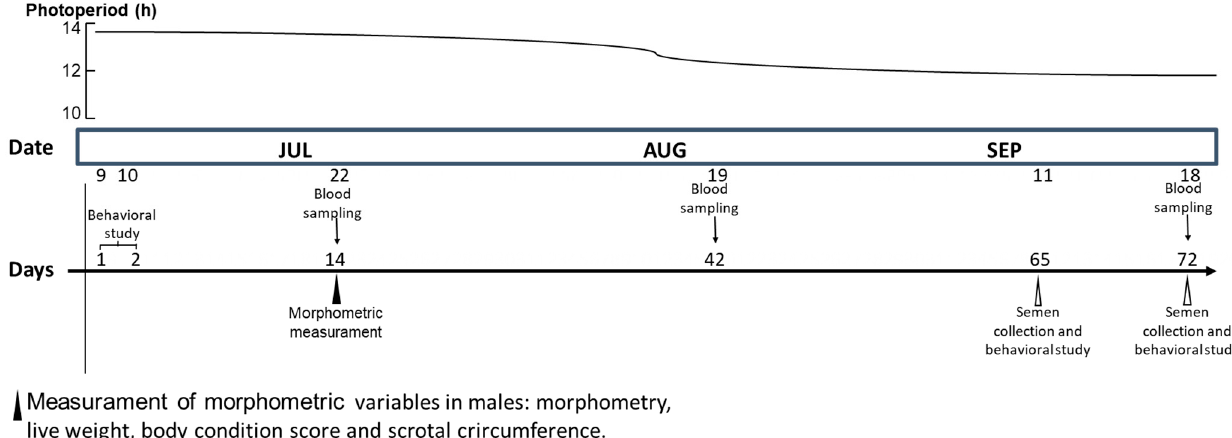
Figure 1. Timeline of the main activities completed in the experimental period. We conducted a behavioral study in all the experimental units ( n = 24) to determine the Dorper males’ social rank, either high or low, under intensive management conditions in northern Mexico (25° N) during a photoperiod of decreasing long days (13:41–12:00). In early July, the behavioral test (male-to-male and male-to-female) was carried out in the morning (0800 h × 60 min, two days). In late September, the rams’ height at the withers, length, thoracic perimeter, live weight, body condition score, and scrotal circumference were recorded. In mid-September, two semen collections and a second male-to-female sexual behavioral test were performed. Monthly blood sampling was performed (July, August, and September) to build a hemogram. Throughout the complete experimental trial, there was no indication of any health-related issues in any of the experimental units.